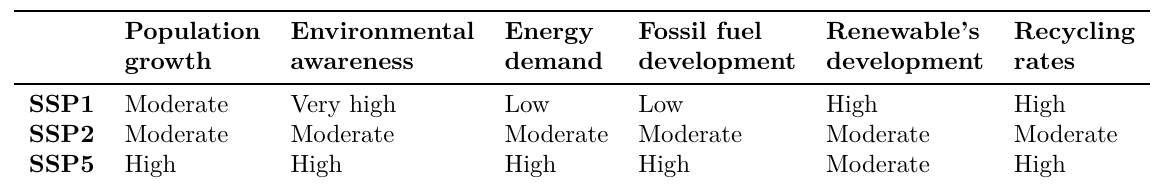
Table 1. Qualitative assumptions for national storylines, based on global narratives and national policies.